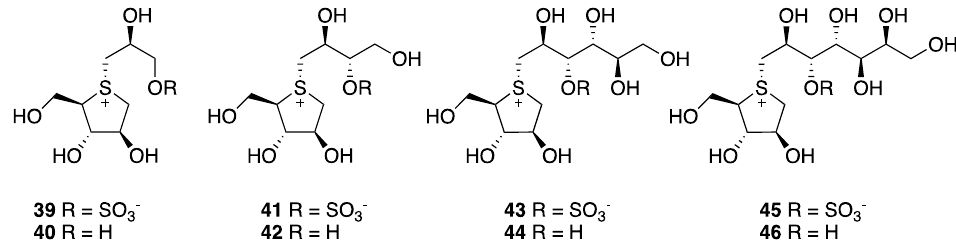
Figure 4. Structure of active compounds in Salacia species.